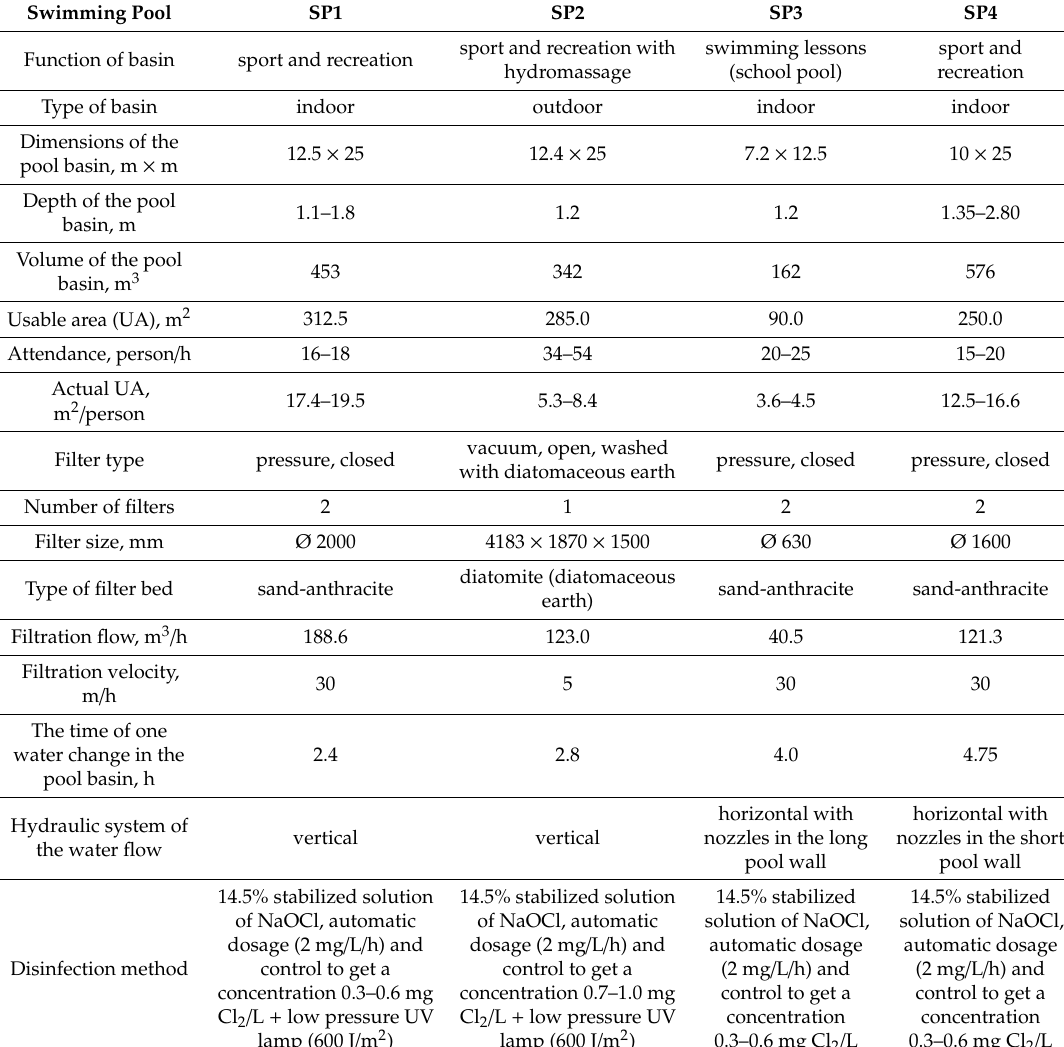
Table 1. The characteristics of tested swimming